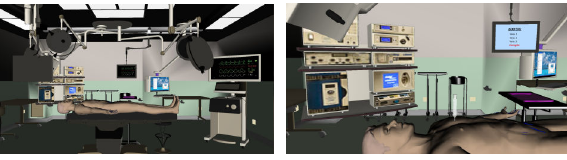
Figure 12. User interface seen within the HMD.